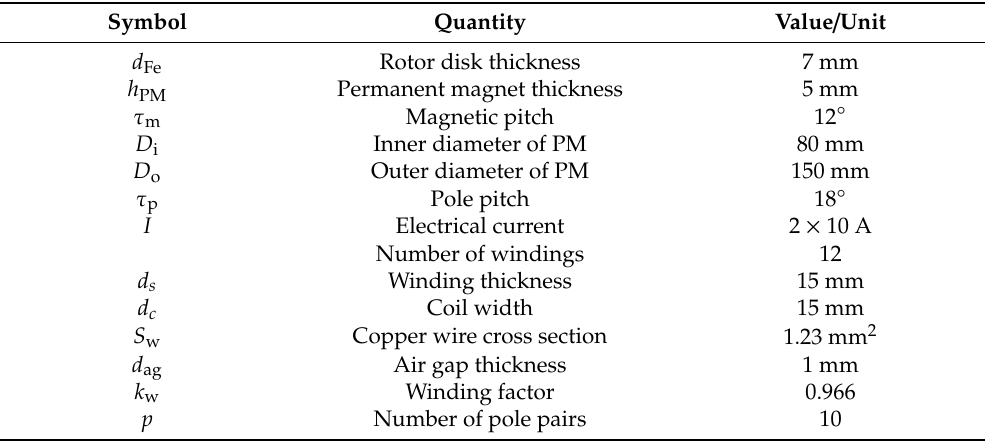
Table 2. This geometry and parameters of the AFPMSM with 20